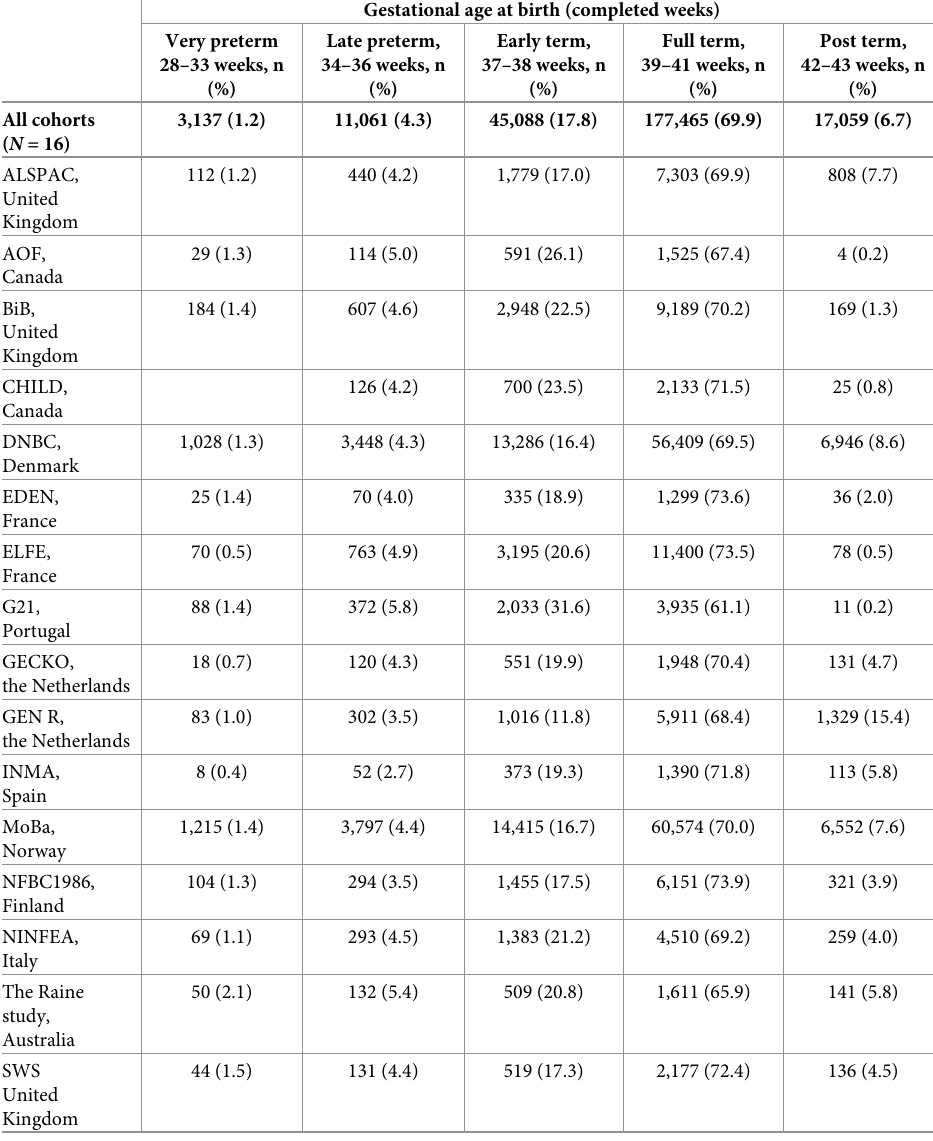
Empty cells represent no available